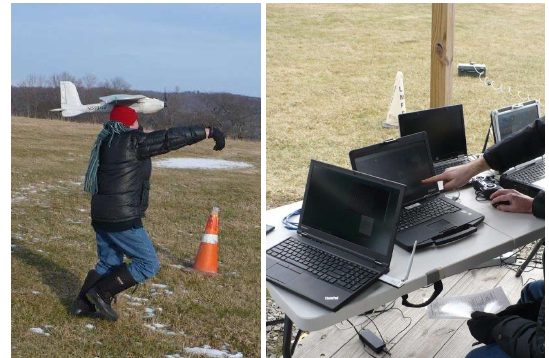
Figure 14. Flight tests with Desert Hawks III.